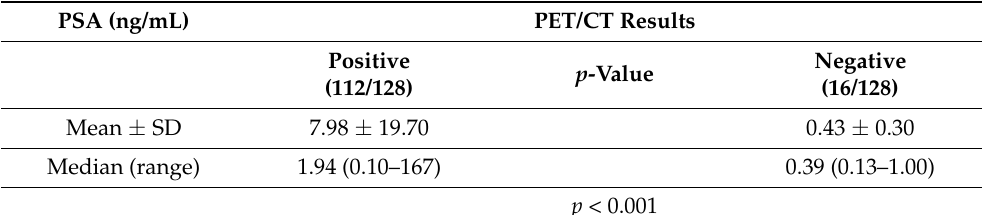
Table 3. Positive vs. negative [ 18 F]PSMA-1007 PET/CT results in relation to PSA. PSA